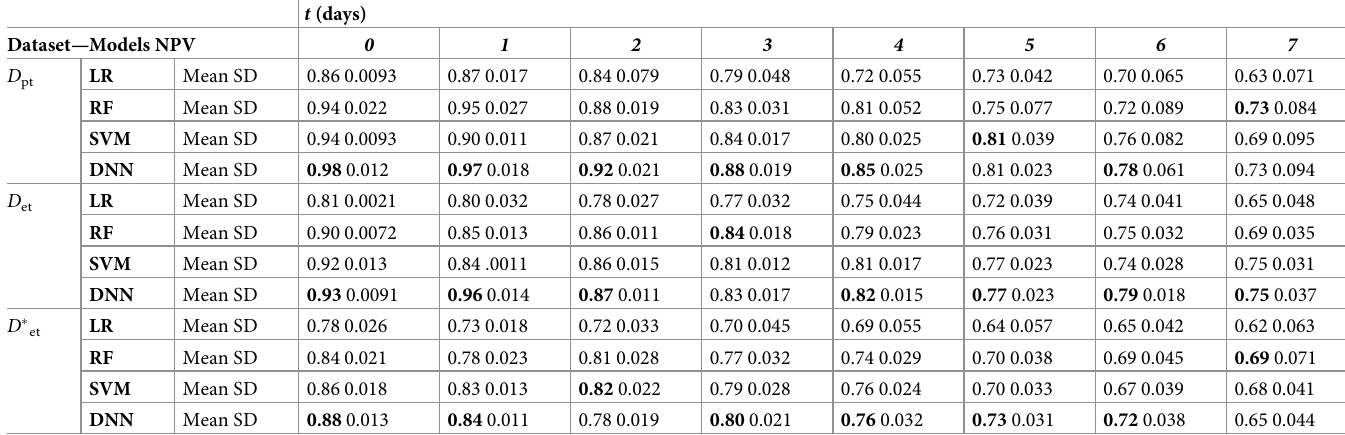
Table 6. NPV results.